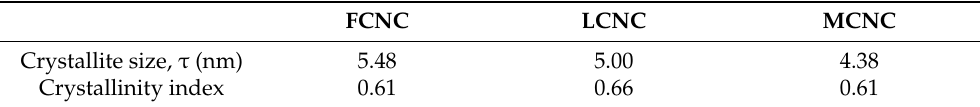
Figure 4. ( a ) 1D wide-angle X-ray scattering (WAXS) profiles of various CNCs, ( b ) crystallinity index, and ( c ) the ratio of cellulose II to cellulose I of CNCs. To calculate the crystallinity index and the ratio, the peak separation was used to separate the background and overlapping peaks of the 1D WAXS integral curves. Dotted lines represent (left) amorphous, and (right) (200) plane of cellulose I, respectively. Table 1. Crystallite size & Crystallinity index of various CNCs.